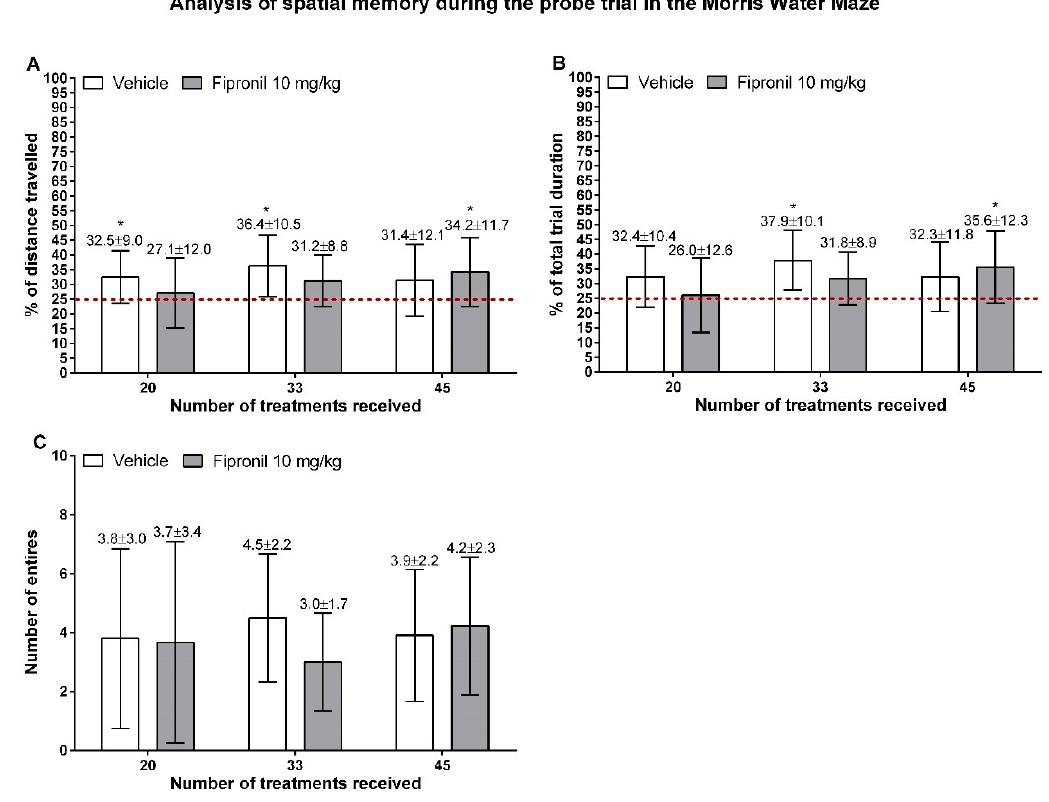
Figure 6. Main indicators of spatial memory as measured during the probe trial during the different sessions of the Morris water maze task. Mean values ± SD are indicated above the bars. ( A ) Relative distance travelled during the probe trial in the target quadrant (former platform location) indicated in percentage of the total distance travelled (Y axis) in function of the number of treatments (X axis). The hypothetical value of 25% travelled in the target quadrant (no recall of the former platform position) is indicated by a red dashed line. ( B ) Relative time spent during the probe trial in the target quadrant (former platform location) indicated in percentage of the total trial duration (Y axis) in function of the number of treatments (X axis). The hypothetical value of 25% travelled in the target quadrant (no recall of the former platform position) is indicated by a red dashed line. ( C ) Number of entries in the former platform location during the probe trial (Y axis) in function of the number of treatments (X axis). *: p ≤ 0.05.